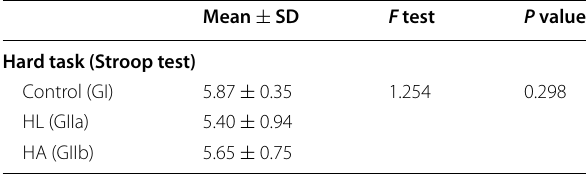
HL hearing loss, HA hearing aid